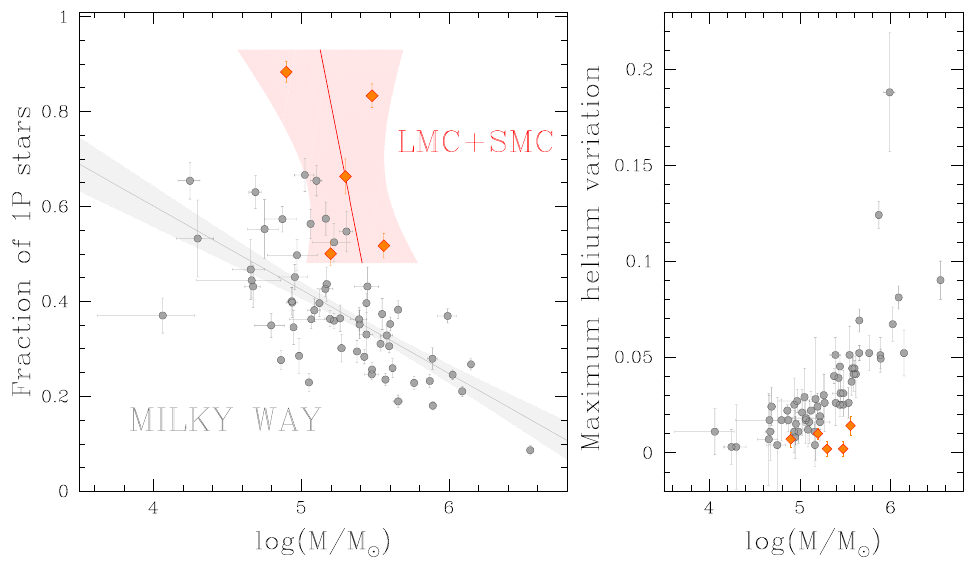
Figure 8. Fraction of 1P stars ( left ) and maximum internal mass-fraction helium variation ( right ) as a function of the present-day mass of the host GC. Gray and orange symbols rep- resent Galactic and Magellanic-Cloud GCs, respectively. The gray and orange lines plotted in the left panels are the best-fit straight lines for the groups of GC with the same color. Masses are from Baumgardt and Hilker [172]; fraction of 1P stars and helium abundances are taken from Milone et al. [24,106], Zennaro et al. [108], Dondoglio et al. [141], D’Antona et al. [173] and from Milone et al. [61], Zennaro et al. [108], Lagioia et al. [164], and D’Antona et al. [173],